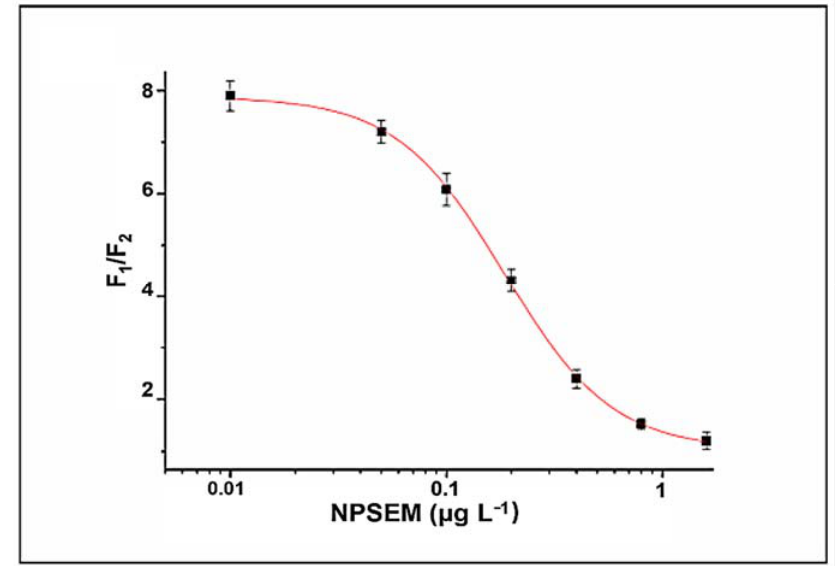
Figure 4. The standard curve of bFQICA method.